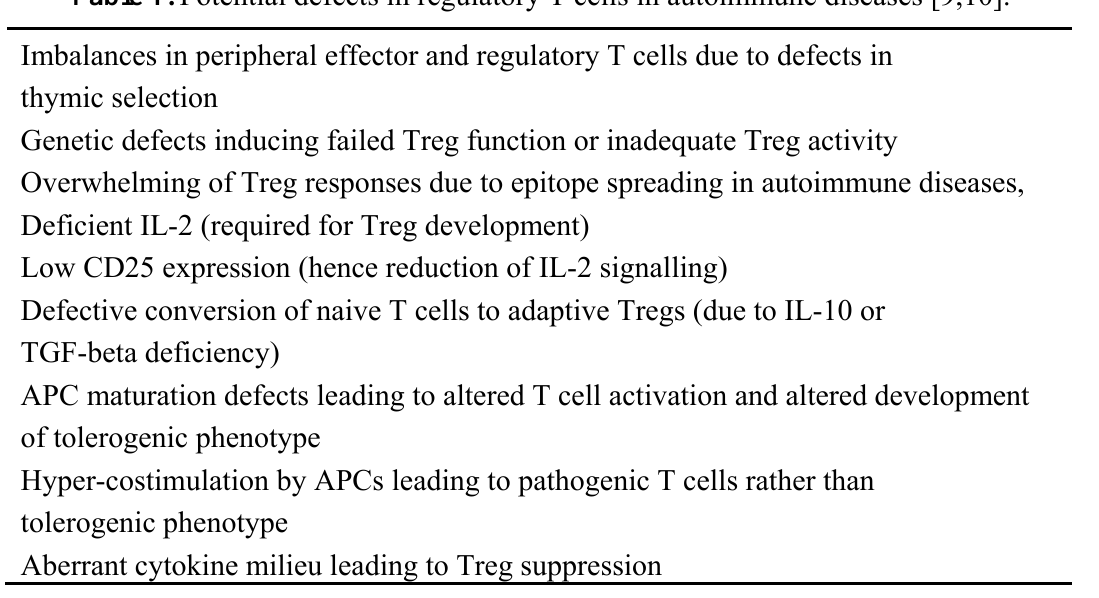
Table 1. Potential defects in regulatory T cells in autoimmune diseases